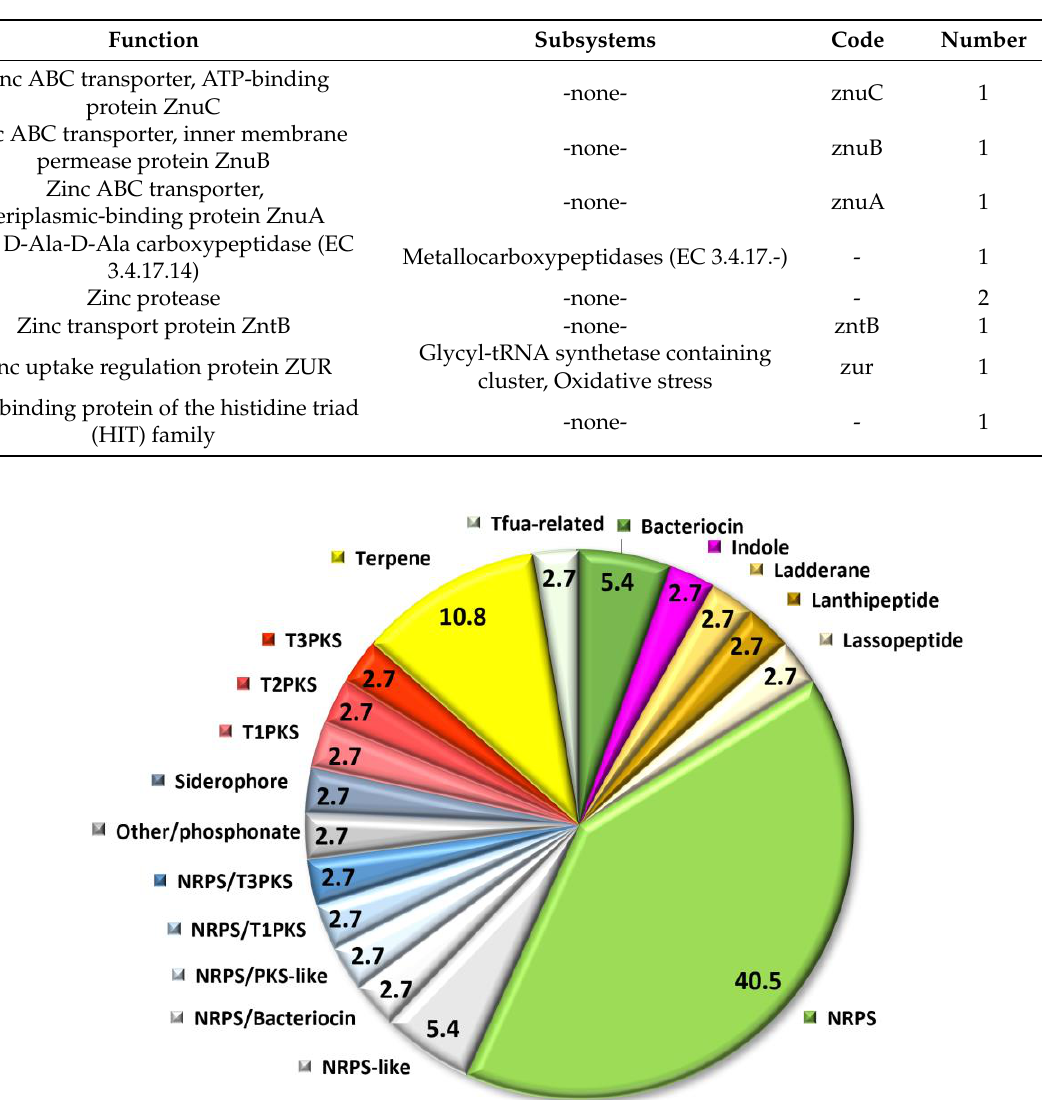
Figure 4. Genome localization and surrounding genes of the alkane synthesis cluster of Plantactino- spora alkalitolerans S1510 T . -4: NADH dehydrogenase (EC 1.6.99.3); -3: Thioredoxin reductase (EC 1.8.1.9); -2: Transcriptional regulator SCO1200, Xre-family with cupin domain; -1: Hypothetical pro- tein; 1: 3-oxoacyl-[ACP] synthase III; 2: Haloalkane dehalogenase-like protein — AMP-dependent synthetase/ligase; 3: NAD(P)H steroid dehydrogenase-like protein; 4: Ribosome protection-type tet- racycline resistance. All genes are in contig NODE_88 of the deposited genome sequence.